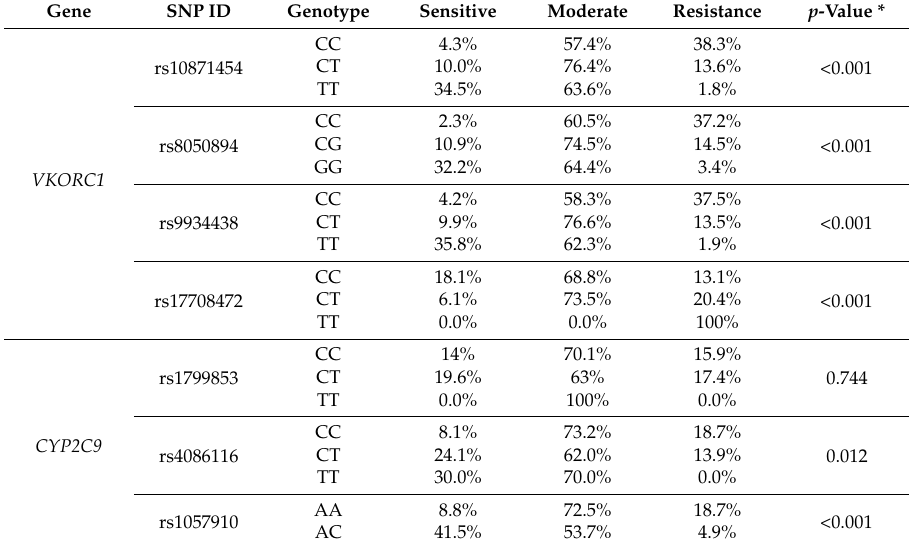
Table 2. Association of VKORC1 and CYP2C9 single nucleotide polymorphism (SNPs) with warfarin sensitivity during the initiation phase of therapy of 212 cardiovascular